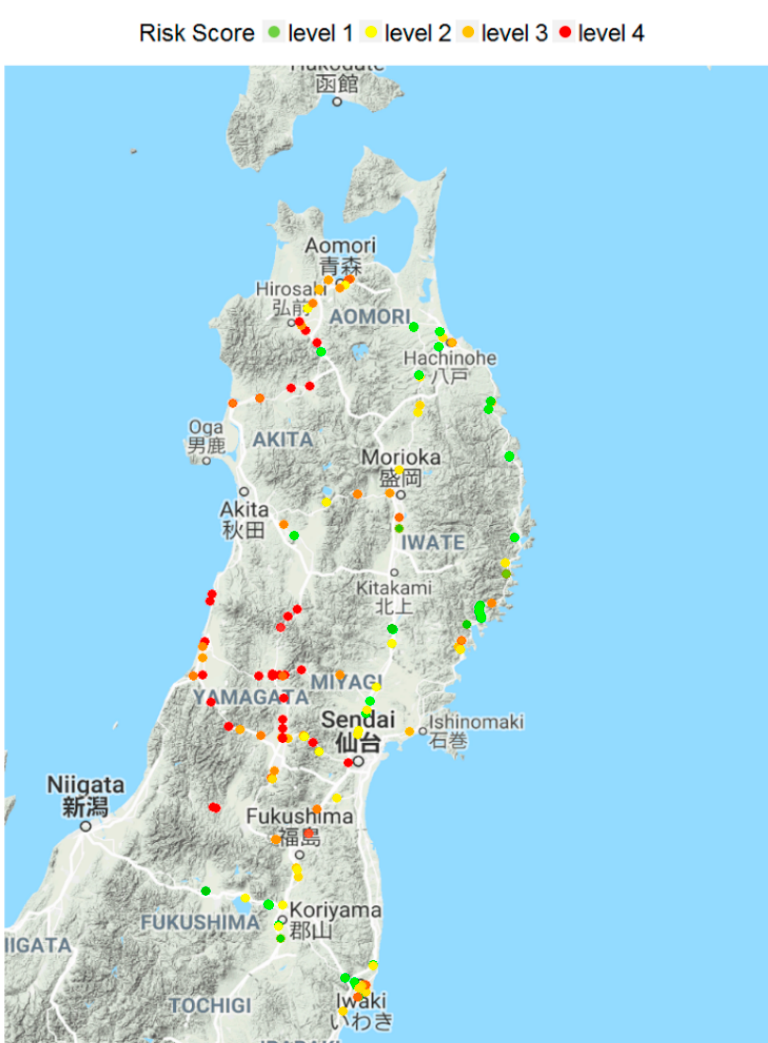
Figure 11. Risk score map for East Japan.